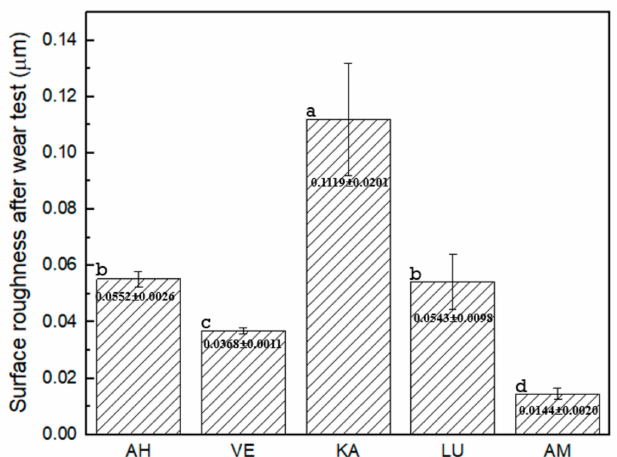
Figure 8. Surface roughness (Ra) after toothbrushing. * Di ff erent letter indicates a significantly di ff erence between that two groups ( p < 0.5).